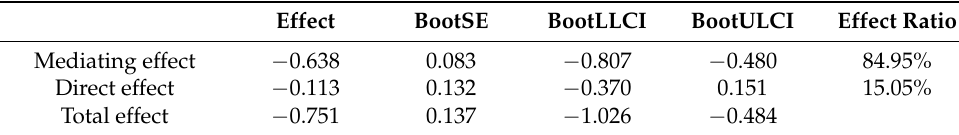
Table 5. Decomposition of total effect, direct effect, and mediating